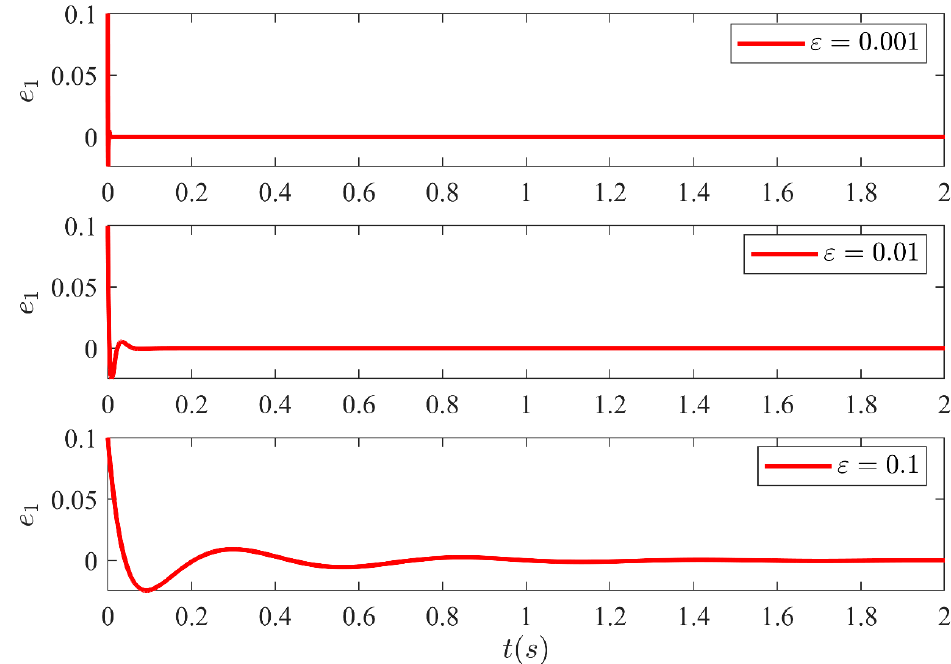
Figure 13. Estimation error e 1 between system state x 1 and the estimated state ˆ x 1 of the HGO for Figure 13. Estimation error (cid:1857) (cid:2869) between system state (cid:1876) (cid:2869) and the estimated state (cid:1876)(cid:3548) (cid:2869) of the HGO for Figure 13. Estimation error (cid:1857) (cid:2869) between system state (cid:1876) (cid:2869) and the estimated state (cid:1876)(cid:3548) (cid:2869) of the HGO for three different values of (cid:2013) . three different values of ε . three different values of (cid:2013) .